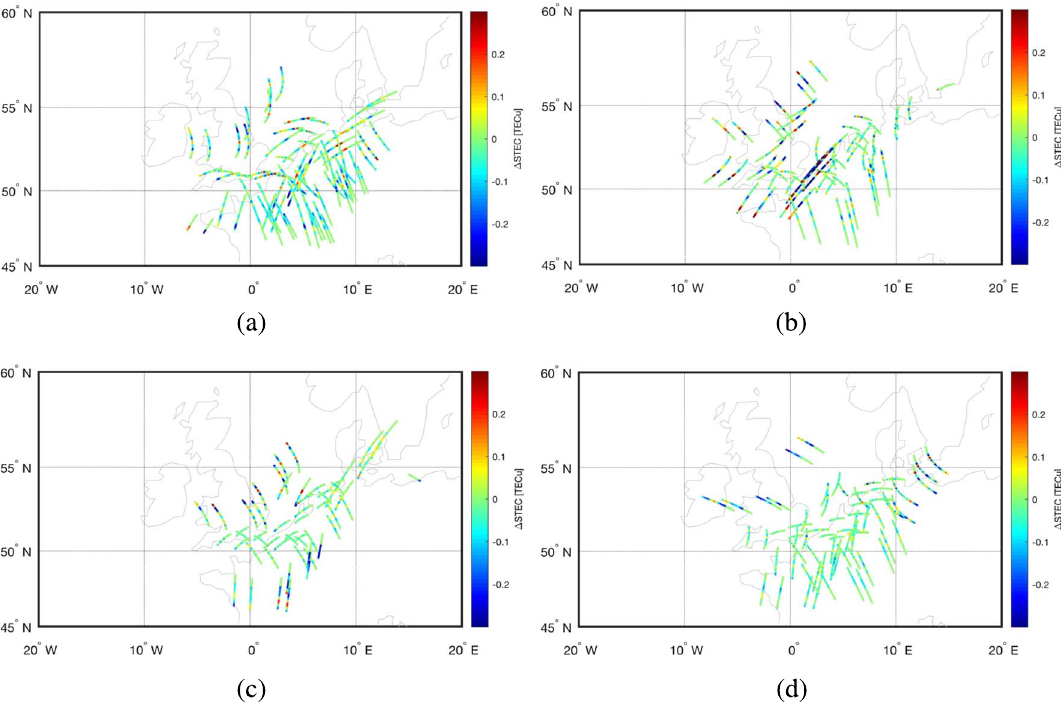
Fig. 15. Hourly geographical distribution of all STEC perturbations in the evening of 18 August 2013: (a) 18:00 – 19:00 UT, (b) 19:00 –